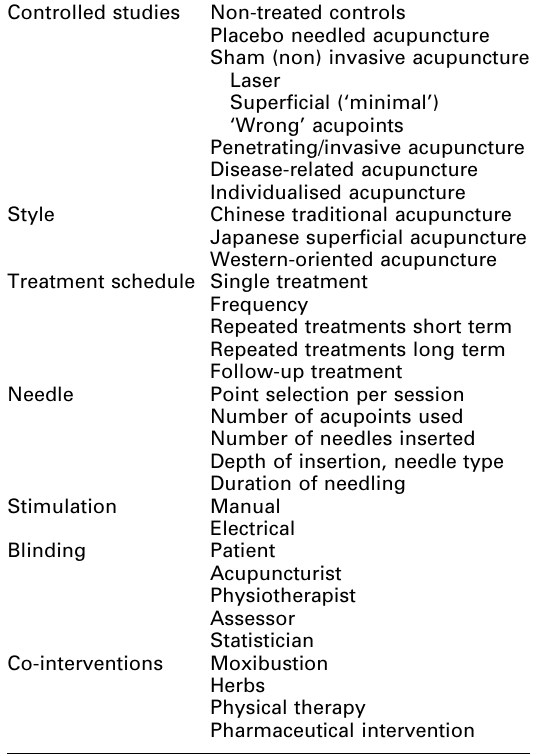
Table 3. Variables in acupuncture Controlled